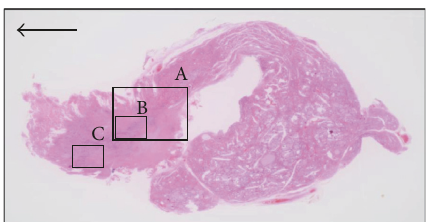
Figure 3: Tumor histopathology. Although the right thyroid lobe and isthmus were evident, left lobe tissue was absent. Most of the tumor represented papillary carcinoma, with a minority portion comprising poorly differentiated carcinoma. No thyroid tissue was observed in the absent portion. Arrow indicates right side. He- matoxylin and eosin staining, ×